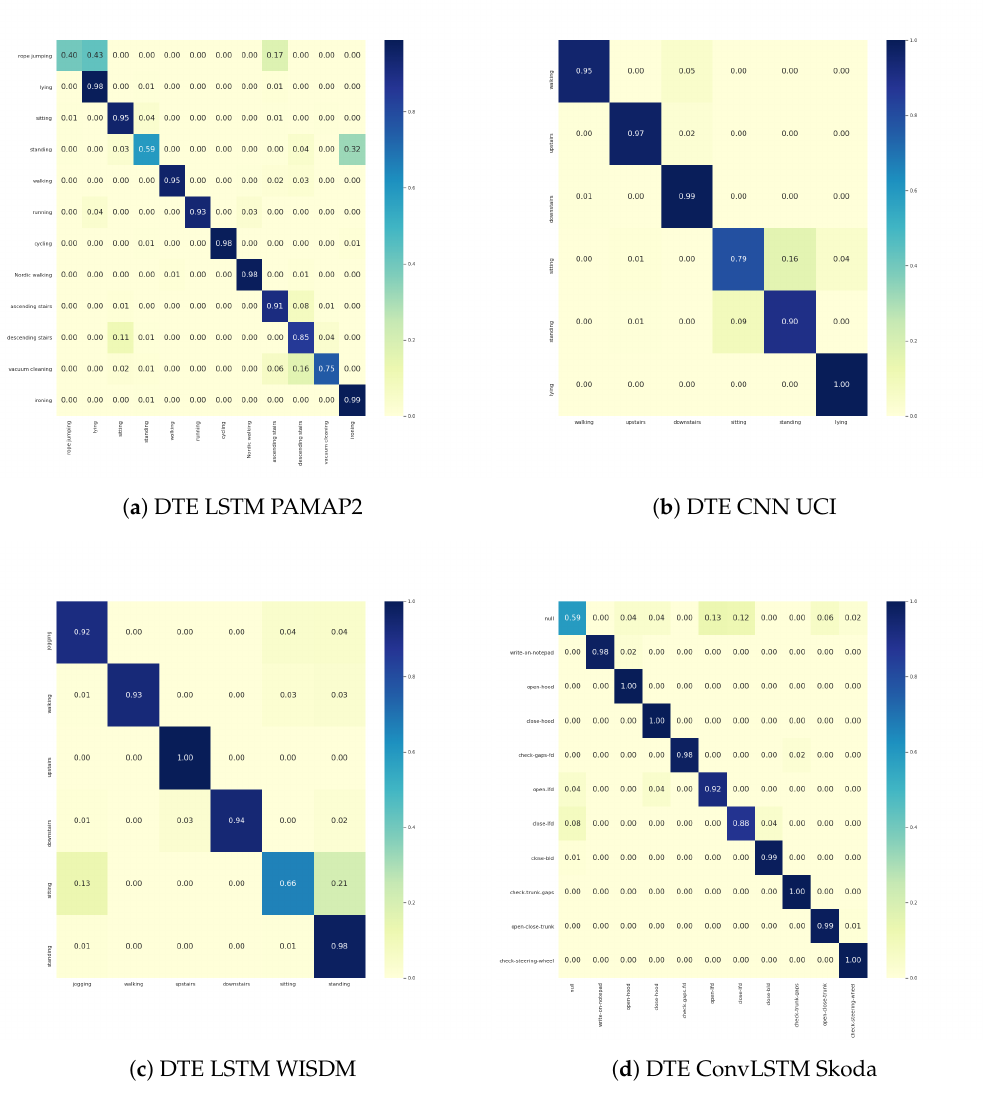
Figure 9. Confusion matrices for best DTE